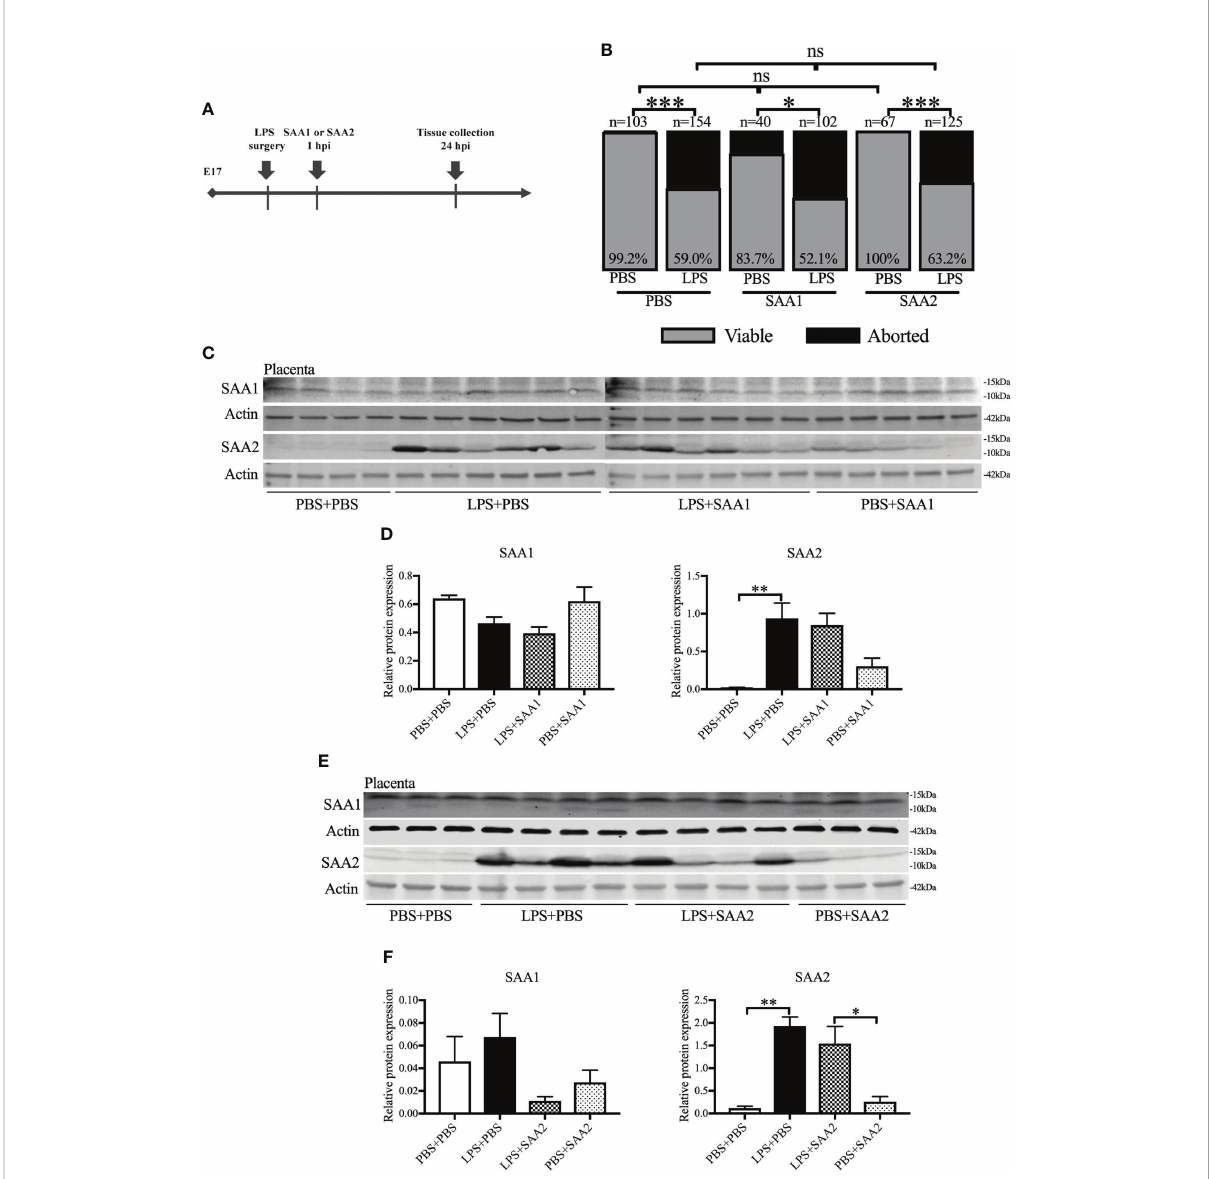
FIGURE 2 The expression of serum amyloid A (SAA) 2 in the placenta increases following intrauterine in fl ammation. (A) Study strategy. On embryonic (E) day 17, CD-1 mice underwent a mini-laparotomy in the lower abdomen for intrauterine injection of lipopolysaccharide (LPS). One hour